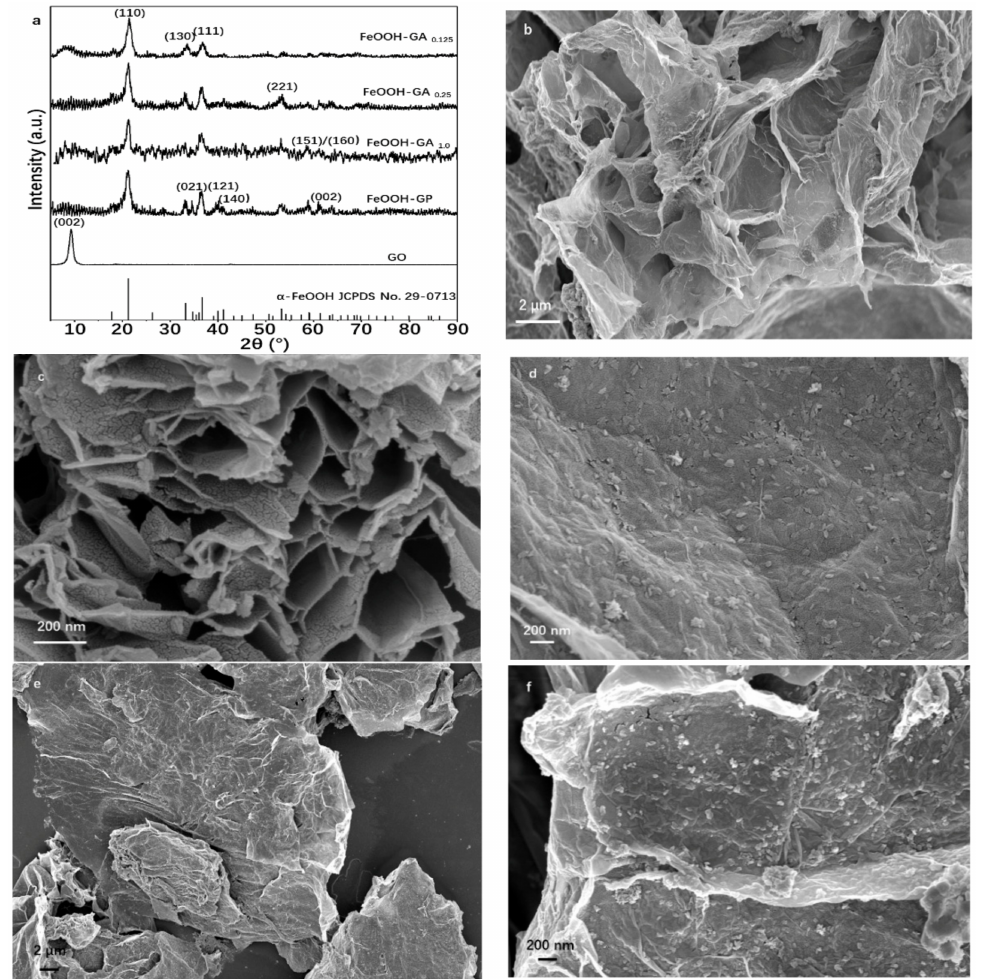
Figure 1. The XRD spectra of FeOOH-GA 0.125 , FeOOH-GA 0.25 , FeOOH-GA 1.0 , FeOOH-GP and GO ( a ). The typical FESEM images of FeOOH-GA 0.25 ( b – d ) and FeOOH-GP ( e , f